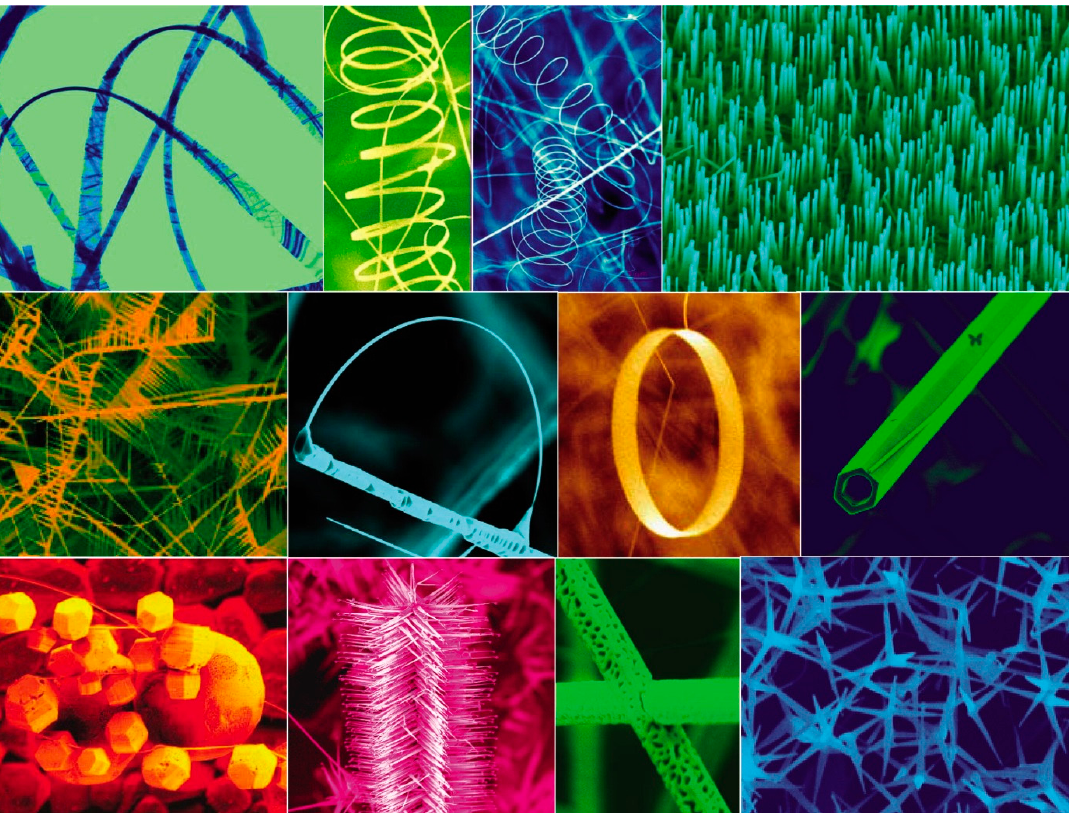
Figure 7. A collection of nanostructures of ZnO synthesized under controlled conditions by thermal evaporation of solid powders. Reprinted from Wang, Z.L., Nanostructures of zinc oxide,